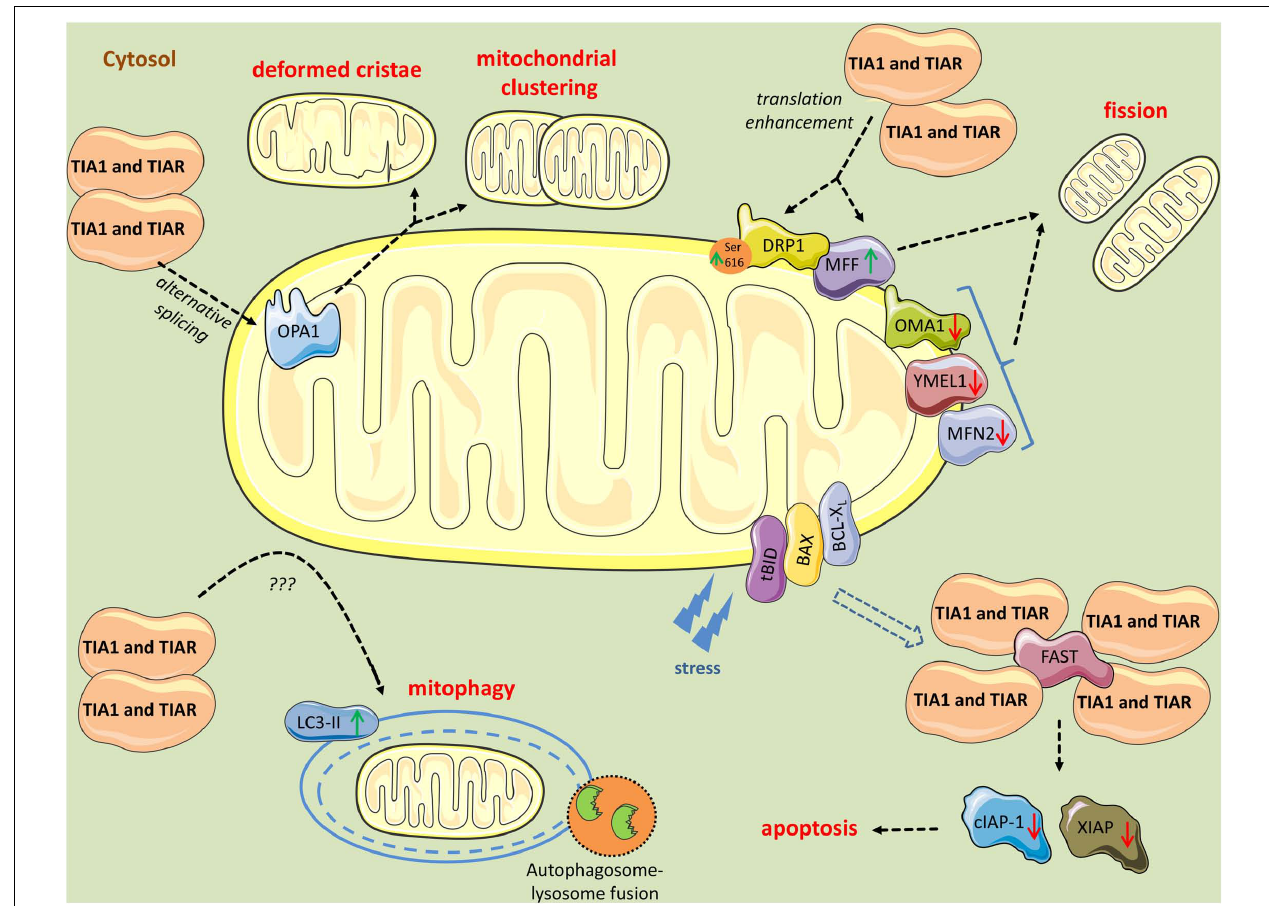
FIGURE 3 | Mitochondrial perturbations induced by TIA1 and TIAR. TIA1 and TIAR mediate exon 4b inclusion in the pre-mRNA of OPA1 generating the OPA1 variant 5, which is associated with a smaller mitochondria, mitochondrial clustering, and remodeling around the perinuclear region. Further, cytosolic TIA1 enhances the translation of MFF mRNA and promotes DRP1 translocation to mitochondria leading to mitochondrial fragmentation. In parallel, TIA1 and TIAR induce modest downregulation of the pro-fusion proteases OMA1, YMEL1, and MFN2, further contributing to the pro-fission phenotype and mitophagy. TIA1 also has pro-apoptotic properties inhibited by FAST. FAST is released from its mitochondrial tether during stress, a process mediated by tBID and BAX. Following its release, FAST binds to TIA1 and prevents TIA1-mediated silencing of mRNAs encoding inhibitors of apoptosis, such cIAP-1 and XIAP . When TIA1 is in excess, it binds FAST and obstruct its anti-apoptotic events. Finally, TIA1 and TIAR increase LC3-II levels, yet the mechanism is unknown, leading to increased mitophagic